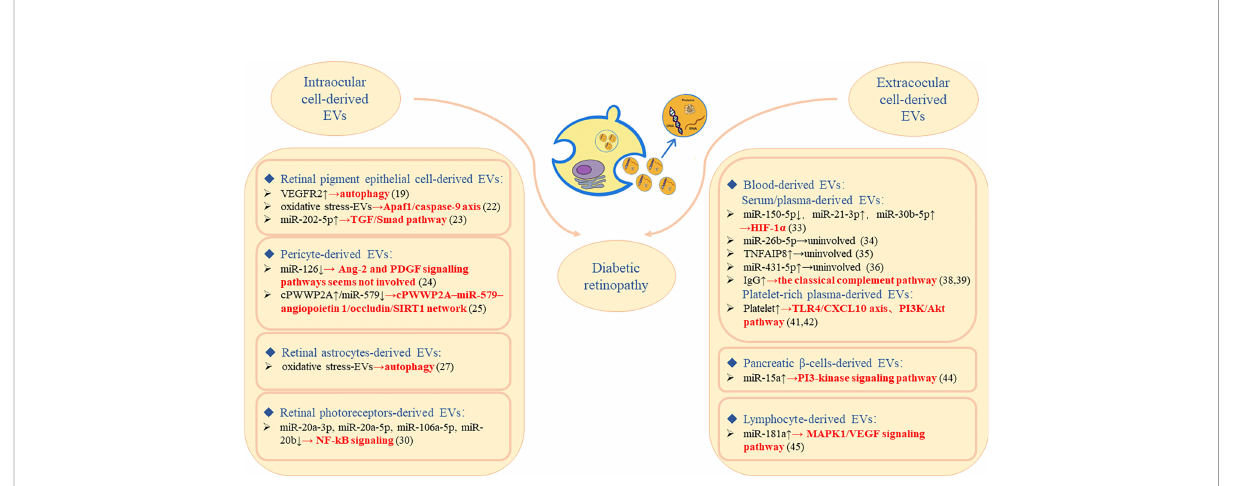
FIGURE 1 The molecular mechanism of DR regulated by intraocular/extraocular cell-derived EVs plays roles in the pathogenesis/diagnosis/prognosis of